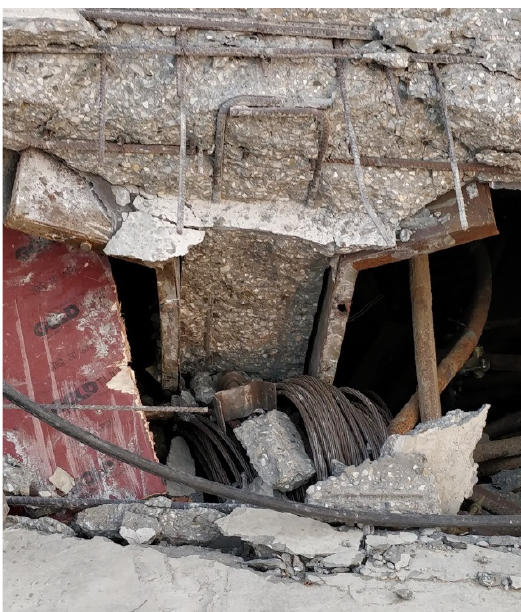
Figure 8. L-bar of fractured beam, anchorage failure of some slab rebar, bearing failure of formwork around bolting holes, and prestressing cables pulled out to significant length and bent.